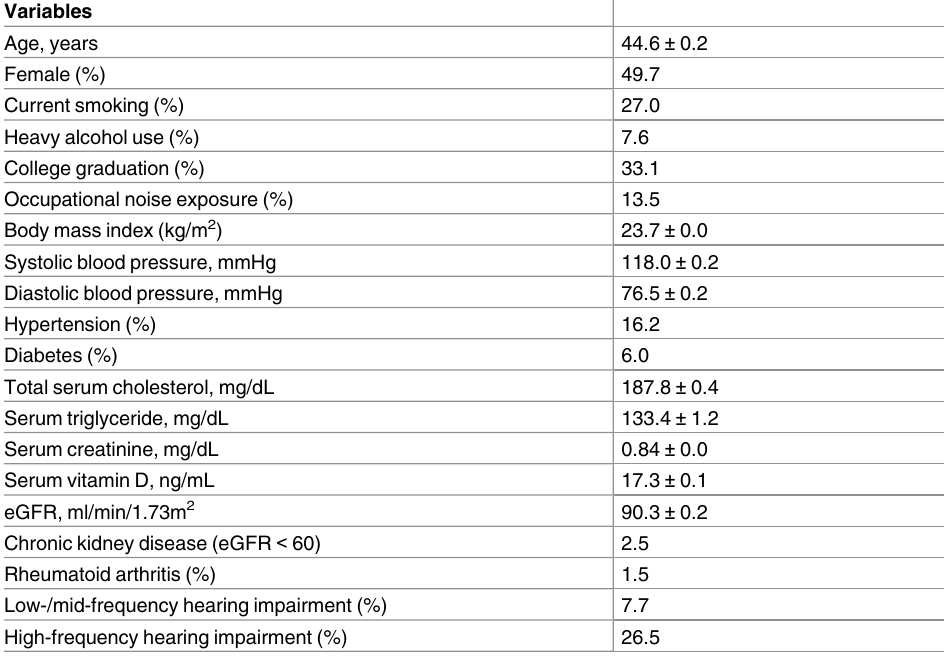
Continuous variables are expressed as mean ± standard error of the mean. eGFR: estimated glomerular filtration rate; “Heavy alcohol use”: consuming alcohol more than four times per week during the month before the interview; “Occupational noise exposure”: a history of > 3 months of loud noise at work that required speaking in a loud voice to be